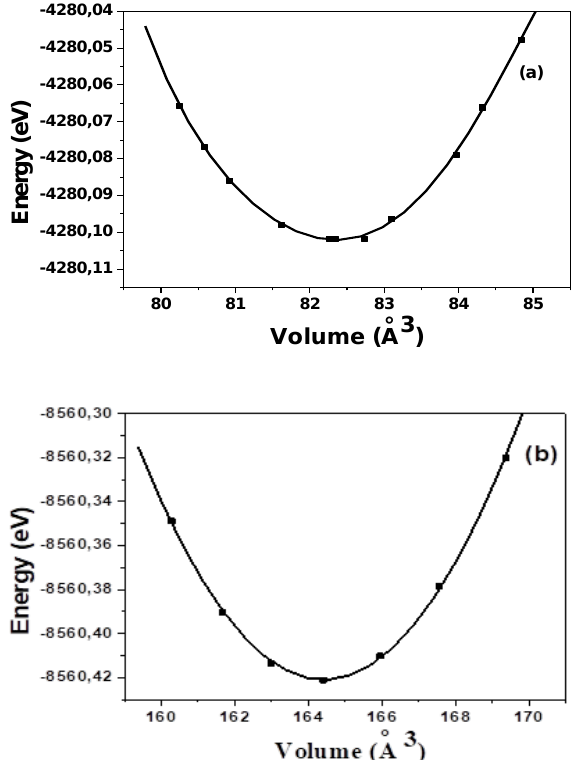
Fig. 4. Energy versus volume for Fe 2 Hf in cubic (a) and hexagonal (b)